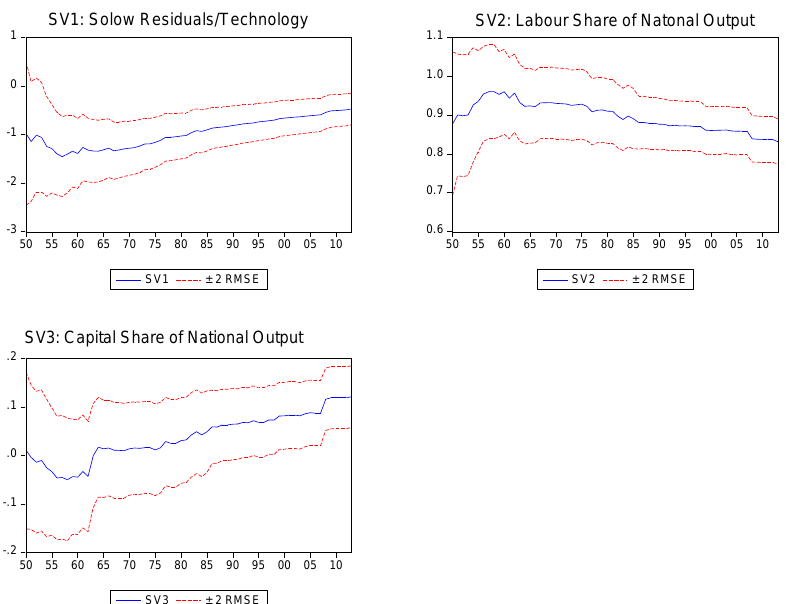
Figure 1: Estimate Structural Vectors